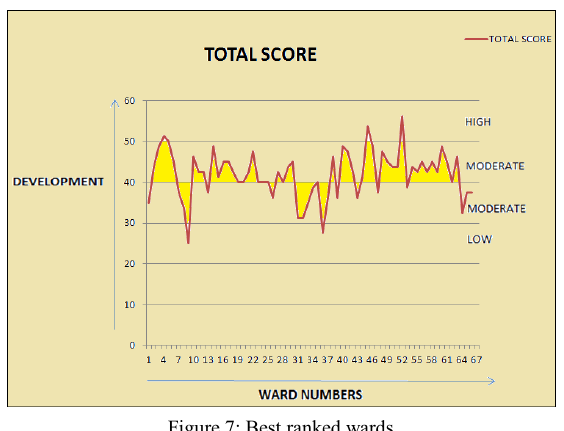
Figure 7: Best ranked wards